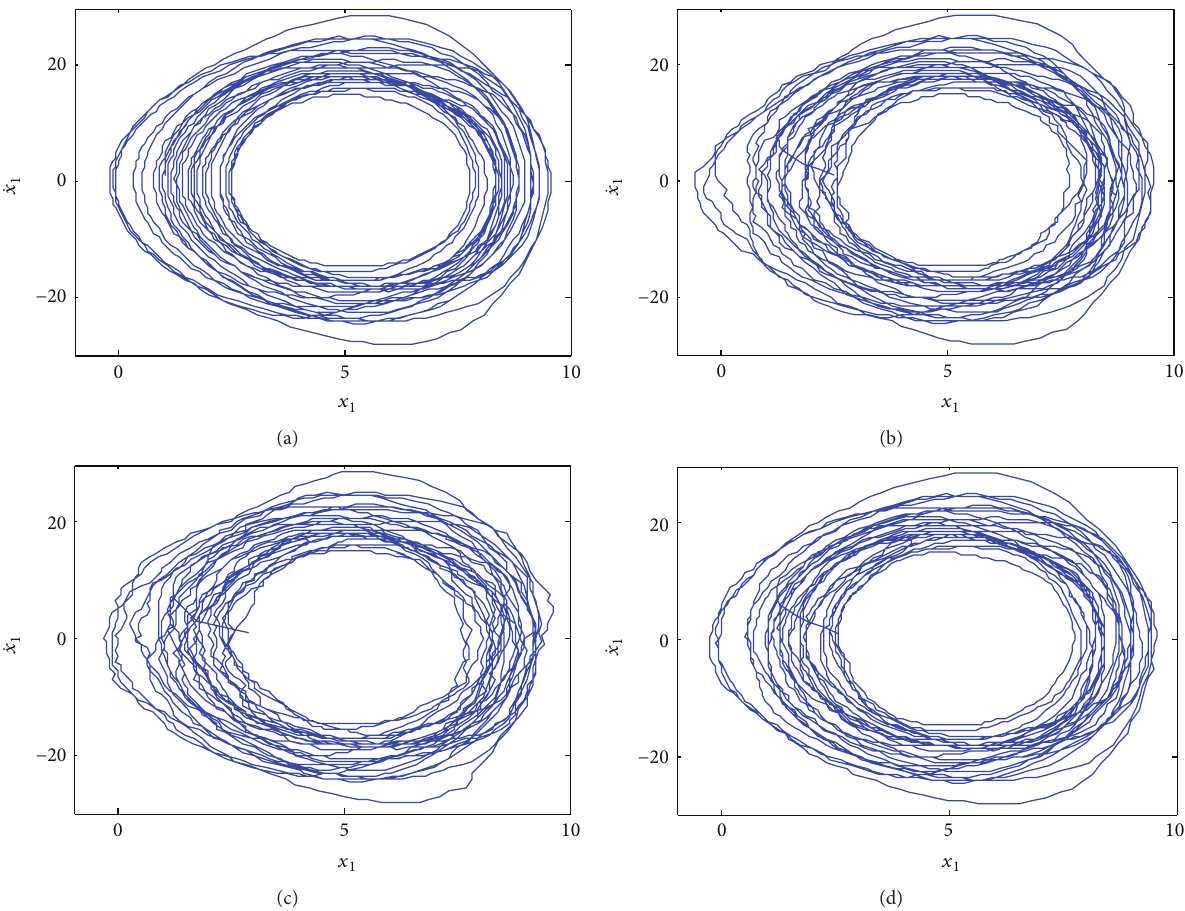
Figure 11: The denoising results of the three methods, wavelet weighted threshold method, traditional EEMD method, and the proposed method. (a) The clean signal. (b) The wavelet weighted threshold method. (c) The traditional EEMD method. (d) The proposed method.